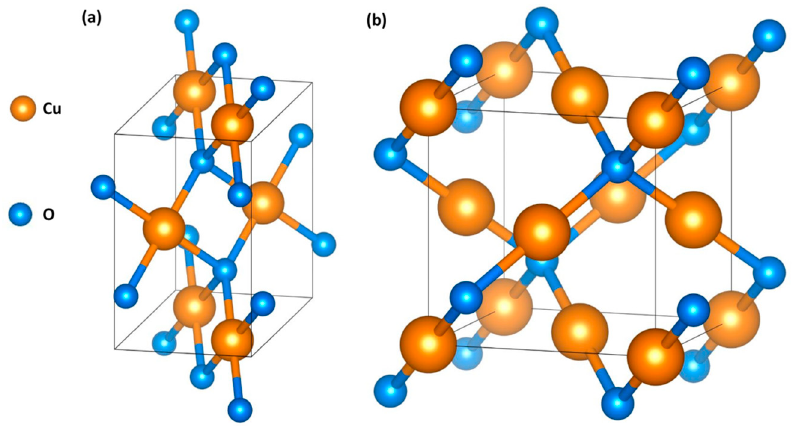
Figure 11. Crystal structure of ( a ) CuO and ( b ) Cu 2 O.